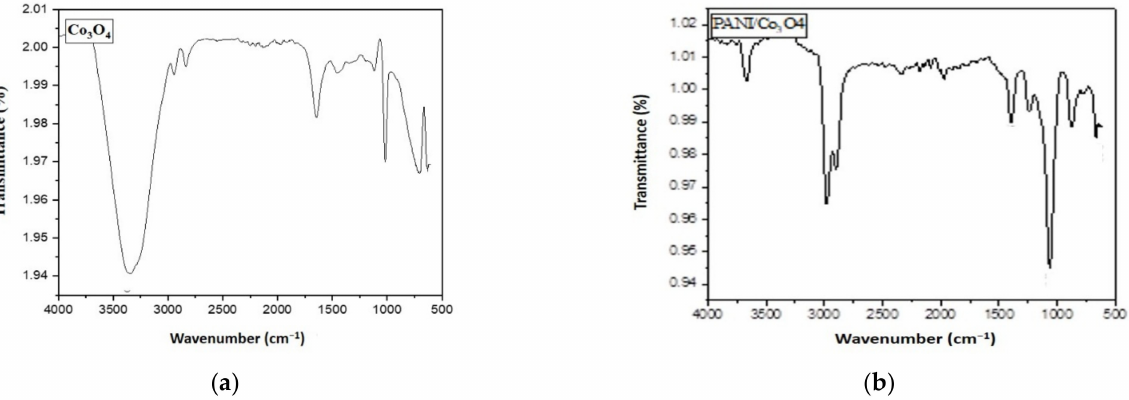
Figure 4. FTIR spectra of ( a ) Co 3 O 4 and ( b ) PANI/Co 3 O 4 nanoparticles.